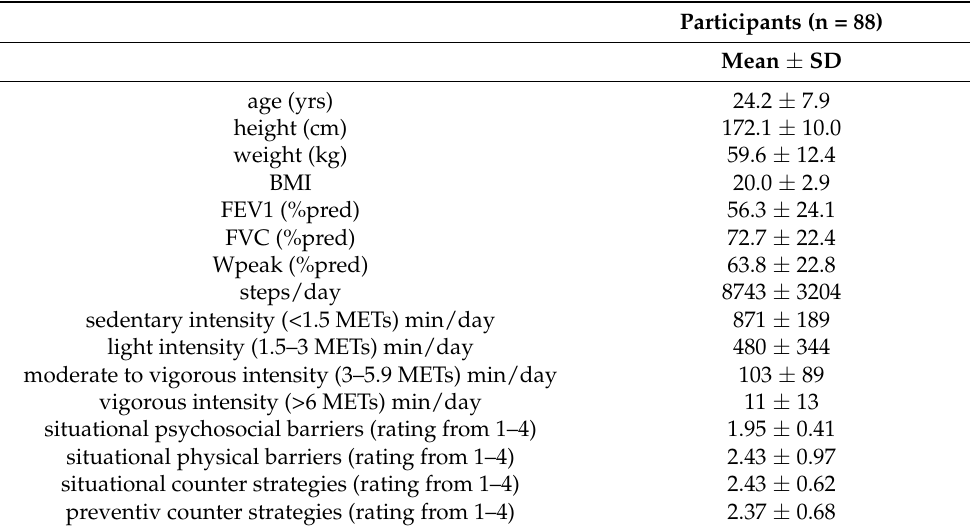
Table 1. Anthropometric characteristics, lung function and steps/day, intensity of physical exercise, barriers, and counter strategies of the participants at baseline.